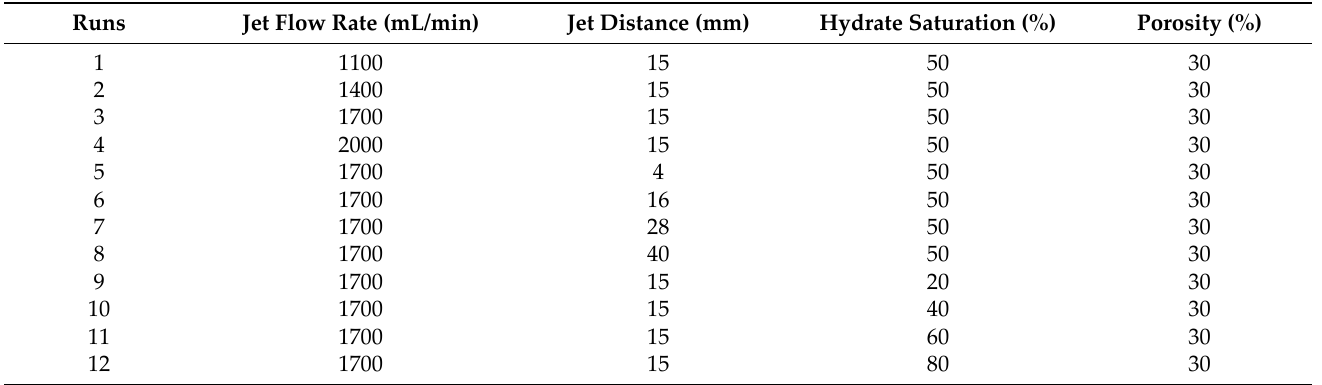
Table 1. Experimental conditions for water jet erosion of